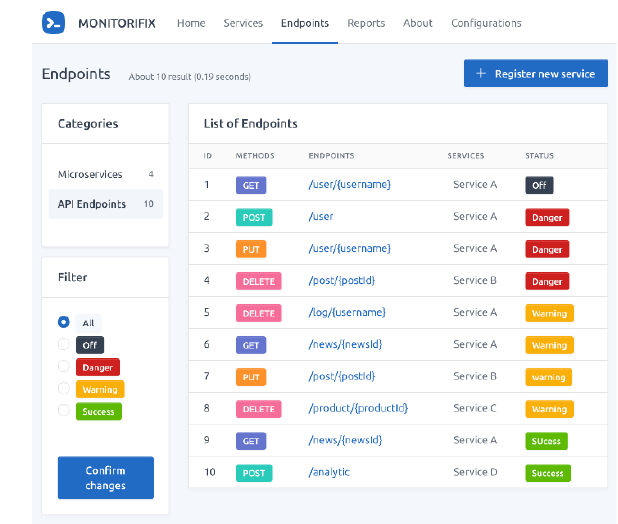
Figure 11. The status of